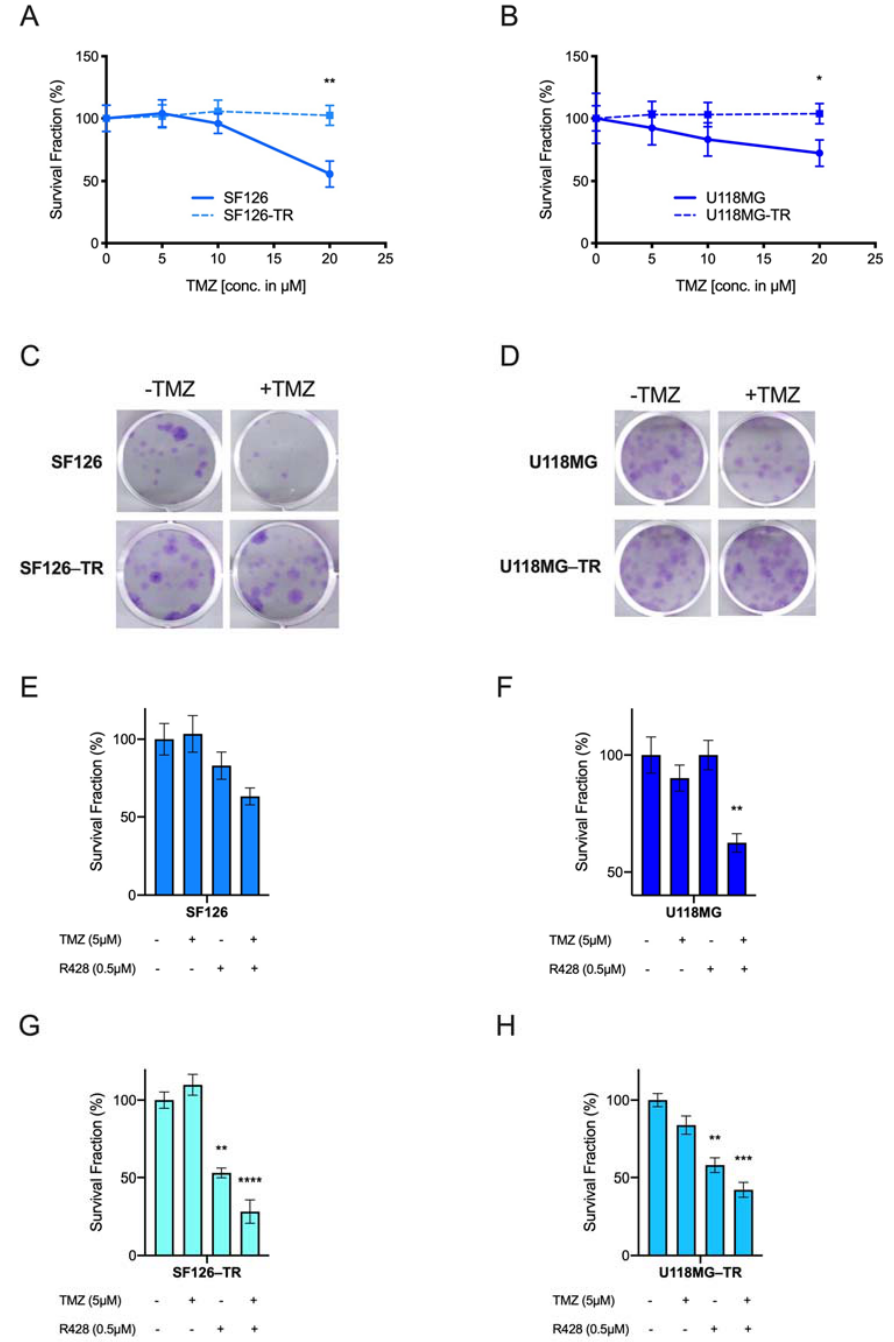
Figure 3. AXL TKI R428 combined with temozolomide (TMZ) increases therapeutic effects: ( A , B ) colony formation assay (CFA) of SF126 and SF126-TR ( A ); and U118MG and U118-TR ( B ) cell lines under TMZ exposure. Paired t -test SF126 vs. SF126-TR: ** p = 0.006; paired t -test U118MG vs. U118MG-TR: ** p = 0.025; ( C , D ) representative images of the CFA of SF126 and SF126 temozolomide- resistant (TR); ( C ) and U118MG and U118MG-TR with and without TMZ treatment ( D ); ( E ) survival fraction of SF126 under TMZ and R428 exposure. Ordinary one-way ANOVA, SF126: p = ns; ( F ) survival fraction of U118MG under TMZ and R428 exposure. Ordinary one-way ANOVA U118MG ** p = 0.0069; ( G ) survival fraction of SF126-TR under TMZ and R428 exposure. Ordinary one-way ANOVA, SF126-TR: **** p < 0.0001. Student’s t -test comparing SF126 with SF126 + R428: ** p = 0.0015; ( H ) survival fraction of U118MG-TR under TMZ and R428 exposure. Ordinary one-way ANOVA U118MG *** p = 0.0002. Student’s t ‐ test comparing U118MG with U188MG + R428: ** p = 0.0028.